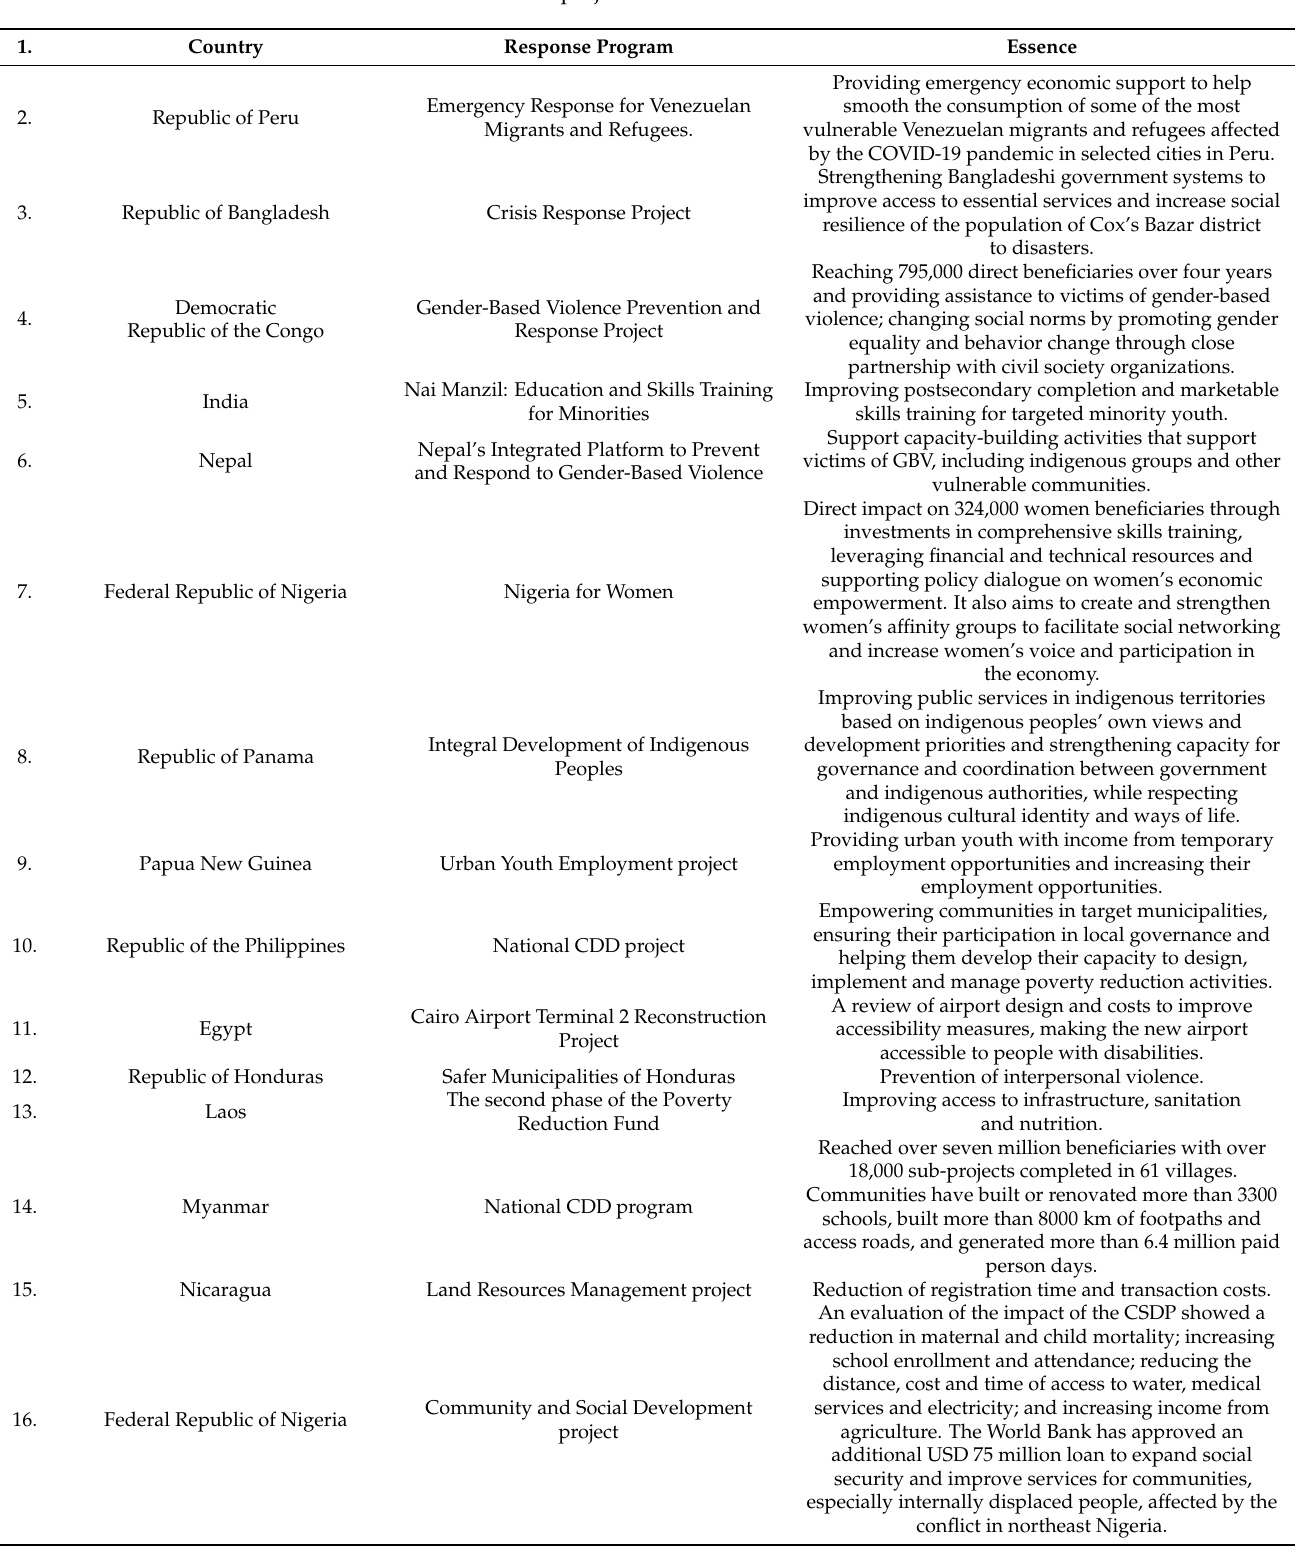
Table 5. Social-inclusion projects of the World